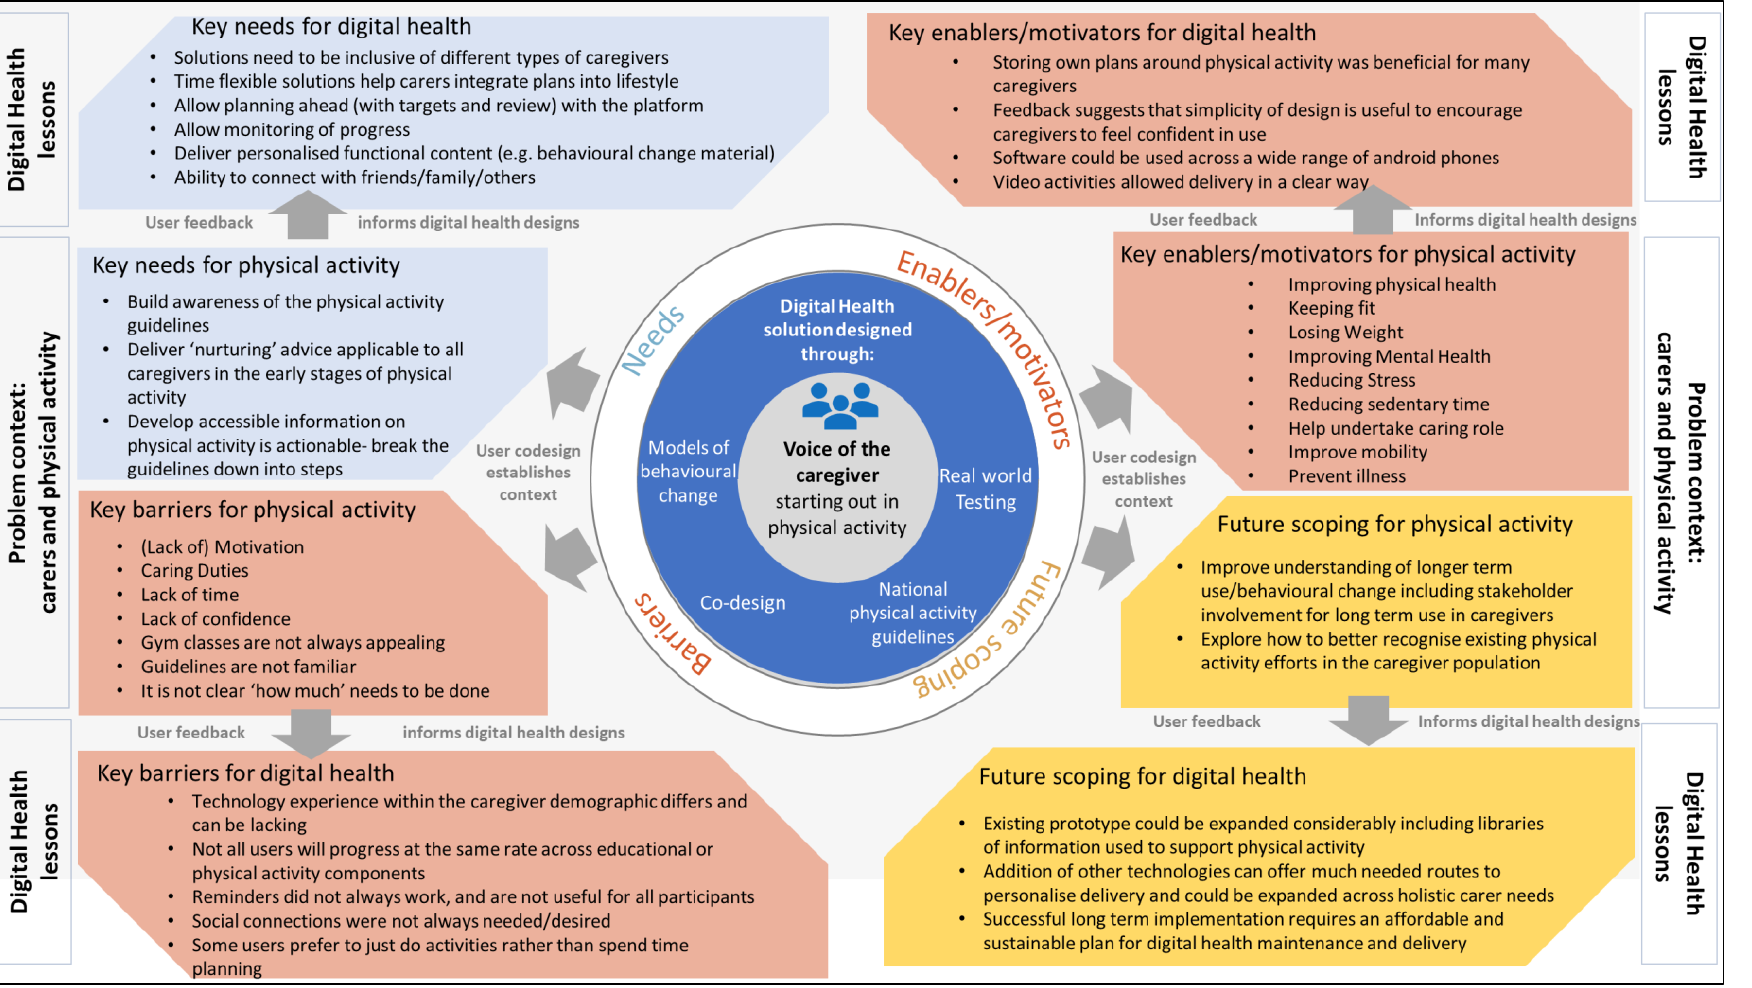
Figure 2. Key themes identified from the development of ‘CareFit’, including the core needs of users, barriers, enablers and motivators and future scoping.